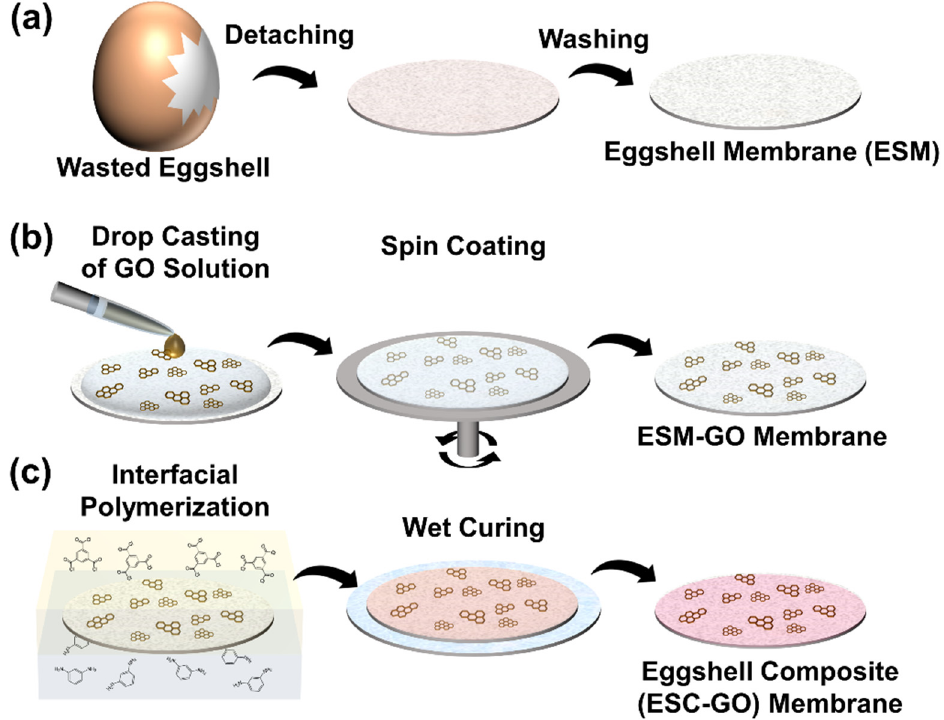
Figure 2. Schematic of biocomposite membrane fabrication process: ( a ) ESM preparation, ( b ) GO coating and ESM-GO membrane, ( c ) active layer fabrication and ESC-GO membrane.